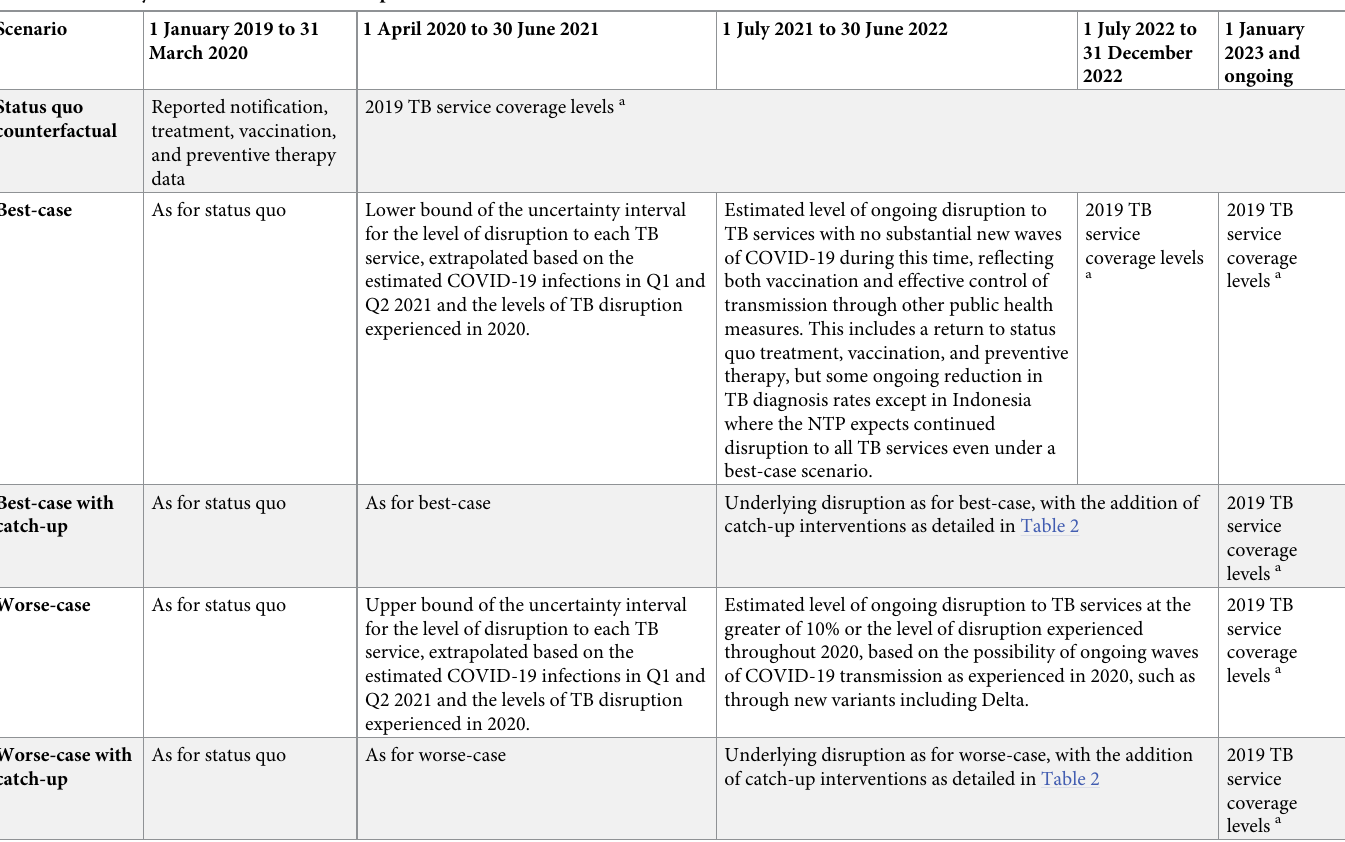
Table 1. Summary of COVID-19-related disruptions to TB services scenarios